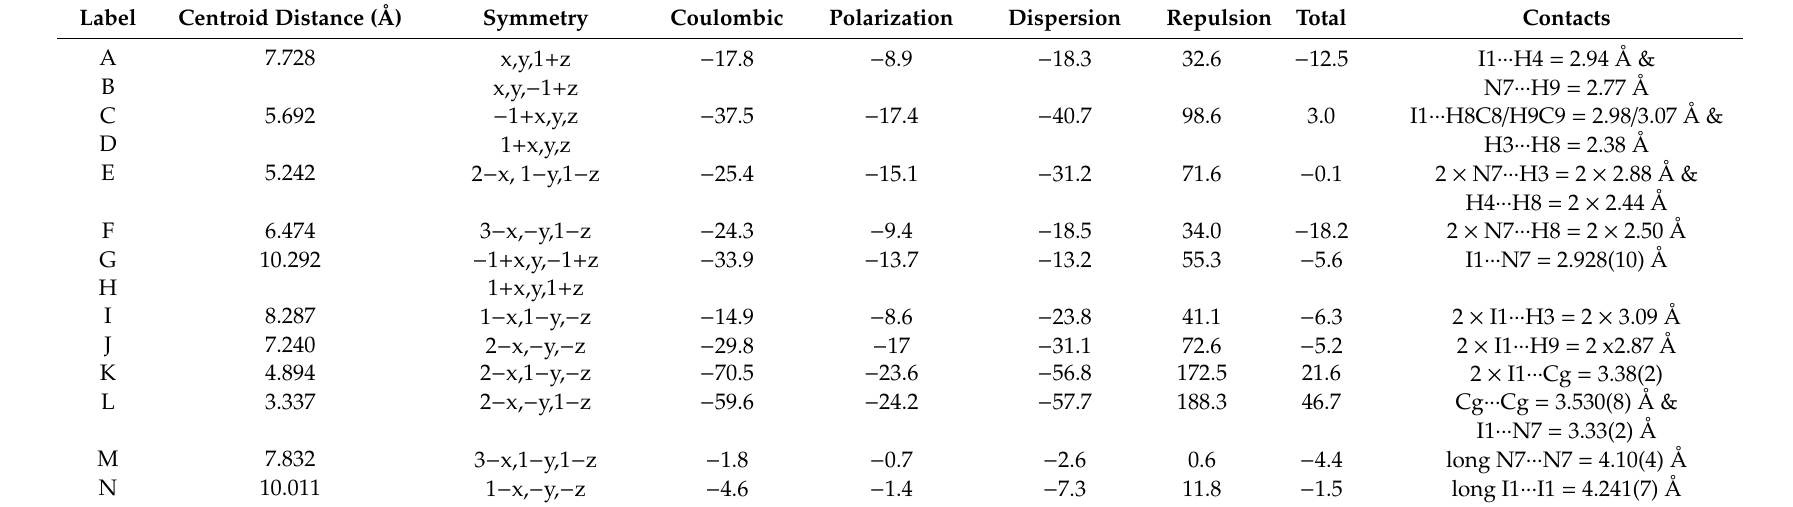
Table 3. PIXEL calculated dimer energies of the phase II polymorph at 5.5 GPa, immediately above the phase transition. All energies are in kJ mol − 1